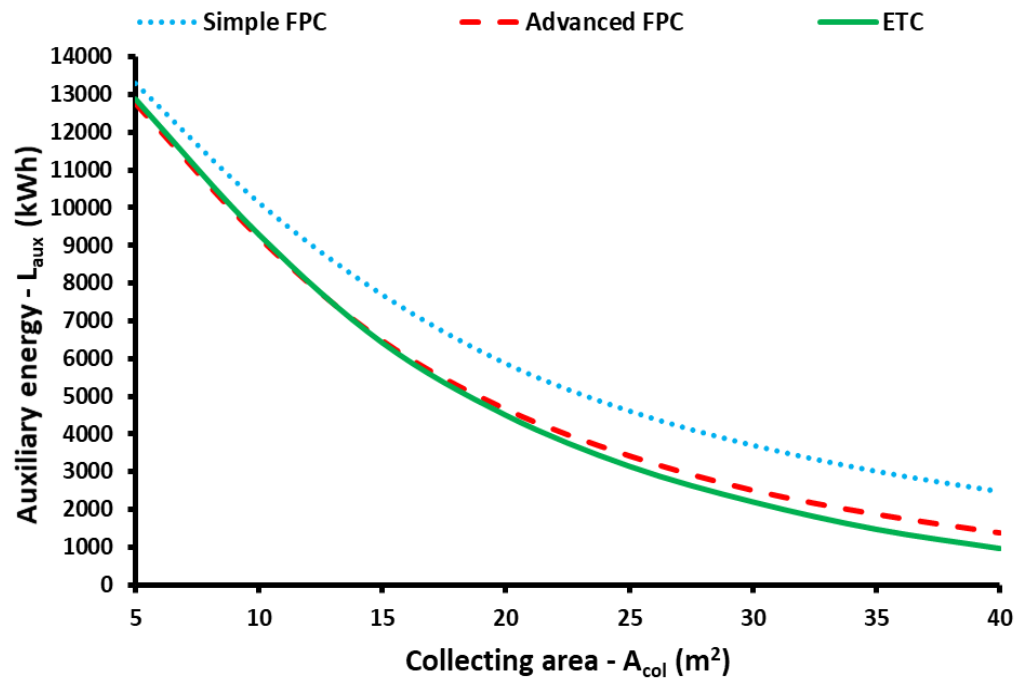
Figure 9. Auxiliary energy consumption with optimum tilt angles for the location of Athens.